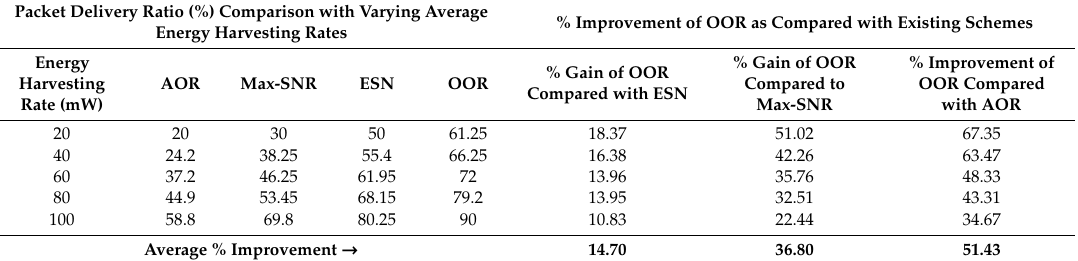
Table 5. Descriptive observations of OOR performance in terms of packet delivery ratio (second scenario). Figure 12. Packet delivery ratio comparison with varying average energy harvesting rates.